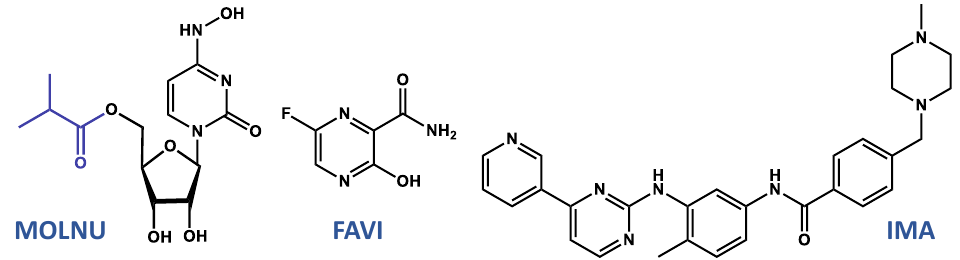
Scheme 1. Structure of the studied compounds molnupiravir (MOLNU), favipiravir (FAVI) and imatinib (IMA). Note: by hydrolysis of the ester group (blue) in MOLNU, isobutyric acid and N(4)- hydroxycytidine (EIDD-1931) are formed which together are referred as hydrolyzed molnupiravir (h-MOLNU) in this work.